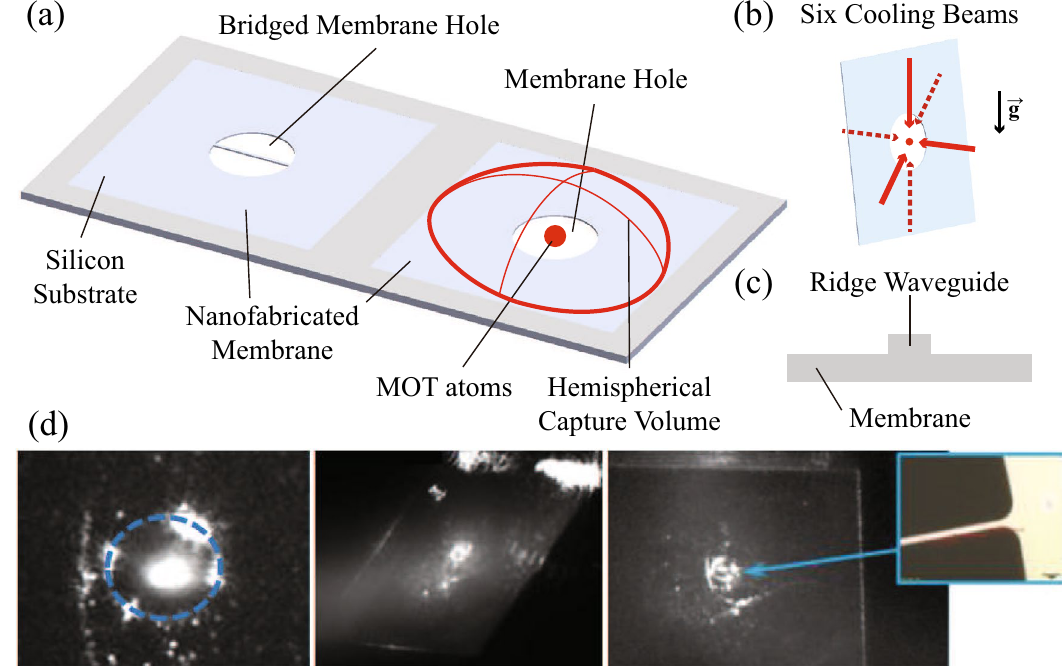
Figure 1. ( a ) Concept of membrane MOT devices. The area of the membrane is 5 mm × 5 mm, and cold atoms in a membrane MOT can be generated in a sub-millimeter diameter membrane hole using six 3.8 mm diameter laser cooling beams, i.e., MOT beams. The bridged membrane hole has a dummy waveguide which imitates a 3- µ m -width membrane ridge waveguide. ( b ) Six MOT beam configuration for a membrane MOT. ( c ) Concept of the membrane ridge waveguide. ( d ) (Left) Image of laser-cooled atoms at the center of a membrane hole without a dummy waveguide. (Middle, Right) Images of laser-cooled atoms at a bridged membrane hole. The diameter of the unbridged/bridged membrane hole is 400 µ m in